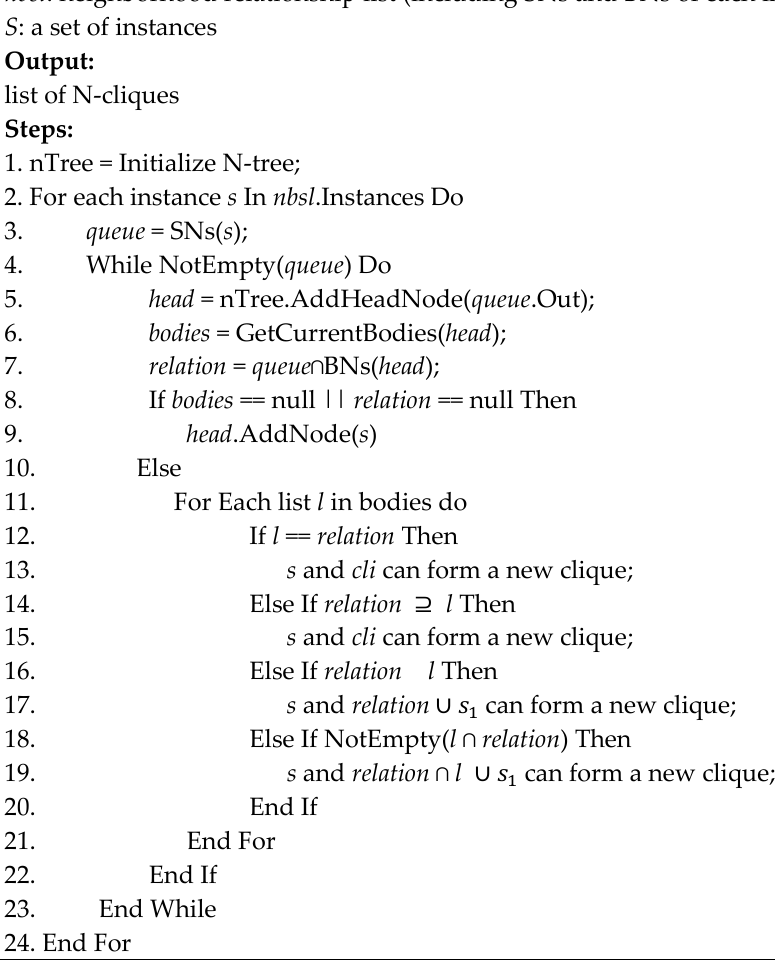
- Figure 7. An example of an N-tree constructed by the NDM. tained in BNs(